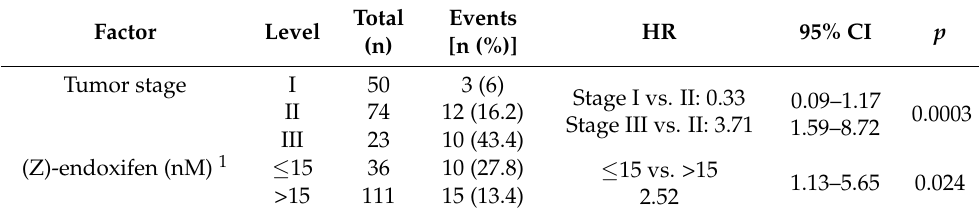
Figure 2. Cox proportional-hazards regression for EFS with modeling of (Z)-endoxifen levels using natural cubic splines (3 knots). ( A ) Univariate analysis, ( B ) multivariate analysis with adjustment for stage; 95% confidence levels are given as dark-grey shaded area.